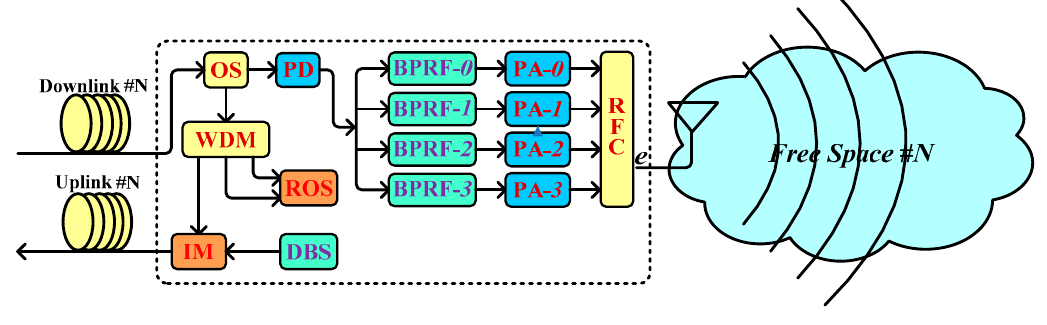
Figure 3. Function block diagram of the radio remote unit (RRU).